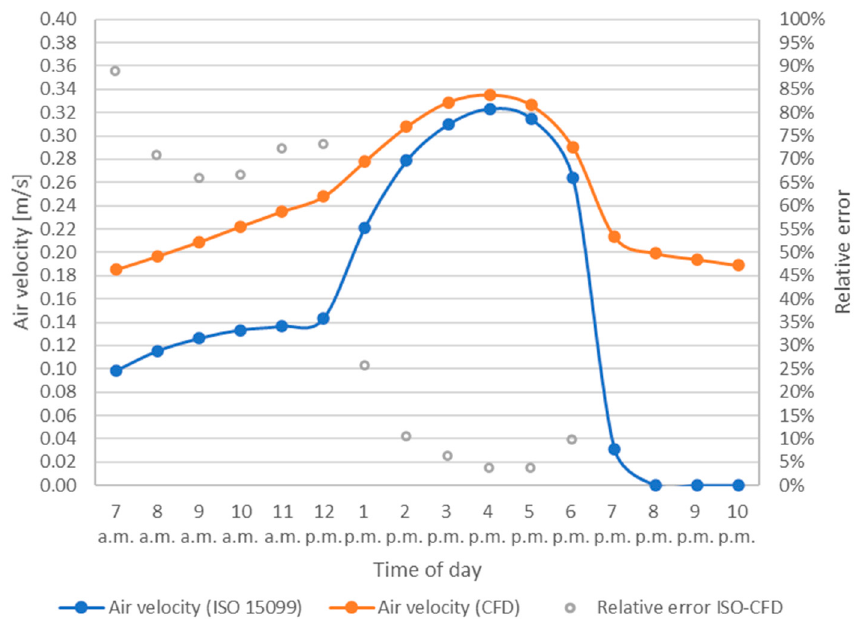
Figure 12. Comparison between the average air velocity values inside the naturally ventilated cavity calculated according to ISO 15099 and provided by the CFD simulations. The graph shows also the RE of the CFD compared to the standard, calculated until 6:00 p.m.